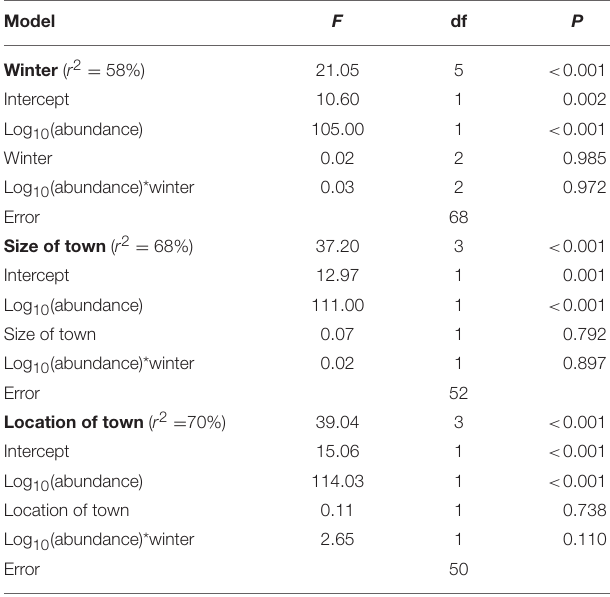
TABLE 4 | Results from the general linear model for species occupancy frequency (log 10